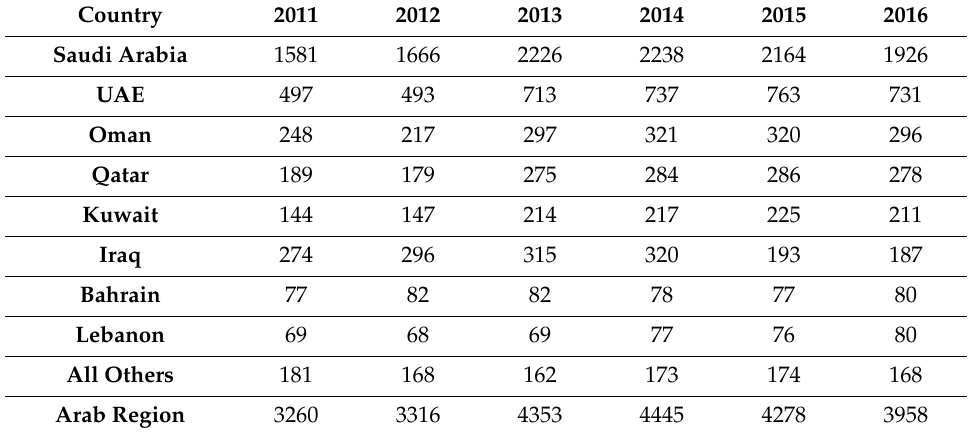
Table 6. The total number of AC units (in thousands) sold in the Arab region during the 2011–2016 period [26].